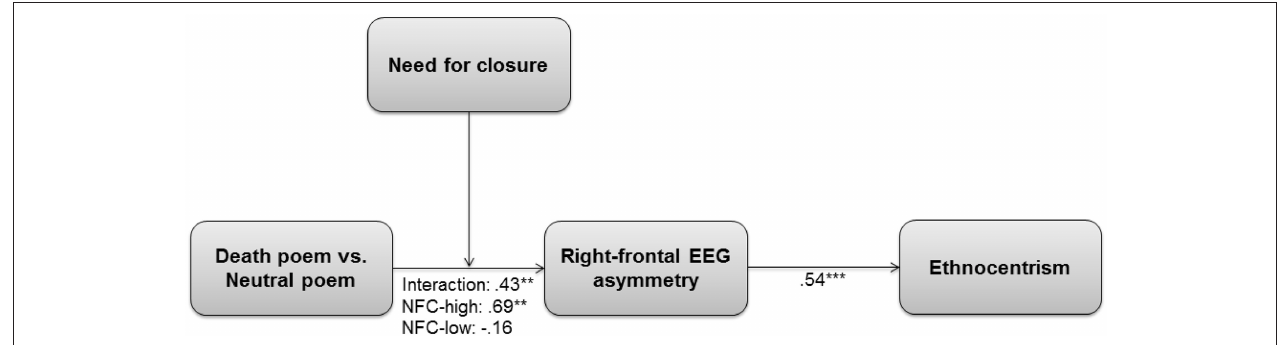
FIGURE 5 | Moderated mediation in Study 2. The death-related poem was coded as 1 and the neutral poem as 0. NFC-high, MS effects under conditions of high need for closure ( SD = 1). NFC-low, MS effects under conditions of low need for closure ( SD = − 1). Standardized regression coefficients ( β ) are